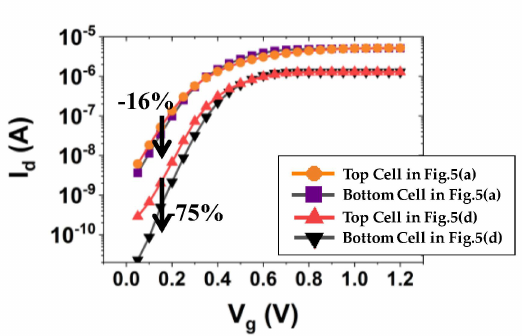
Figure 6. Simulated I d vs. V g to explicitly show the subthreshold characteristics of top/bottom cells, depending on the physical dimensions of the channel hole structure. Note that the subthreshold swing was improved with the smallest physical structure of cells, and its drain current was exponentially affected (increased/decreased).